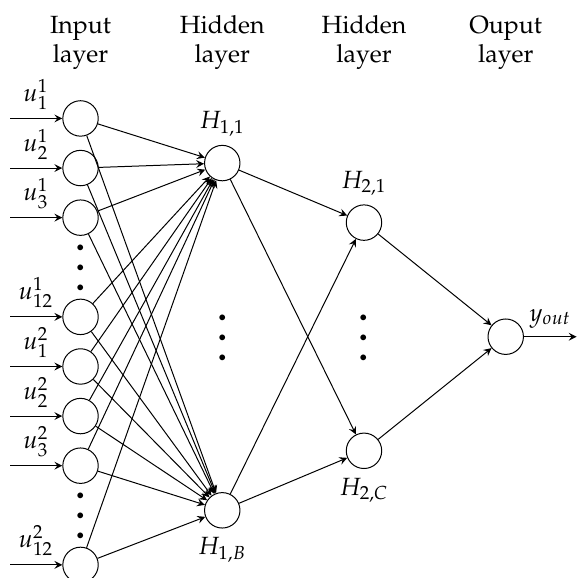
Figure 3. ANN architecture employed for the estimation of similarity between two compounds. Each compound u k is described by 12 energy descriptors, where j is the j th component of the k th j compound, H l , j stands for the j th neuron in the l th hidden layer; B and C are the number of neurons in the first and the second hidden layer; and y out is the prediction of the